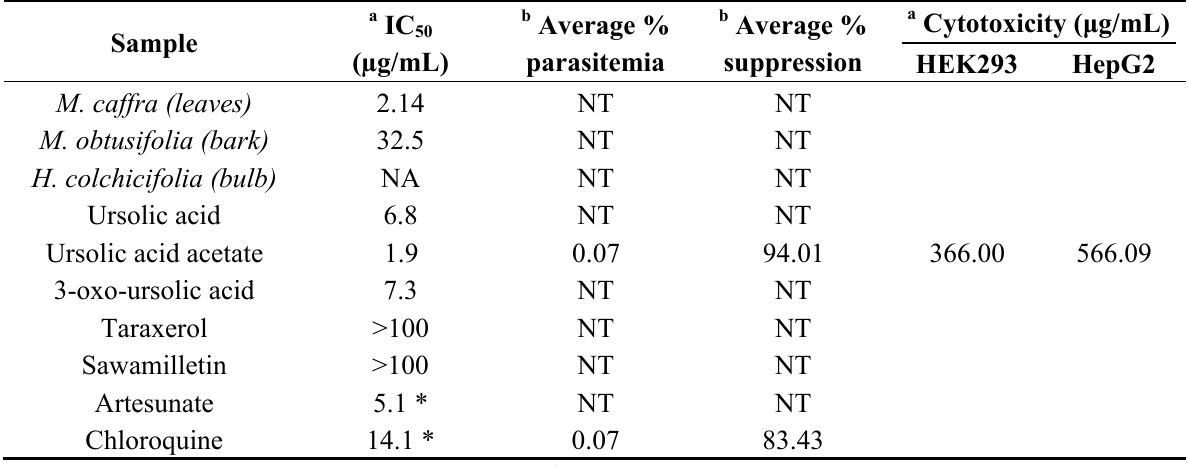
Table 1. Anti-plasmodial activity against Plasmodium falcipurum (CQS) D10 strain ( in vitro ) and Plasmodium berghei ( in vivo ). Sample